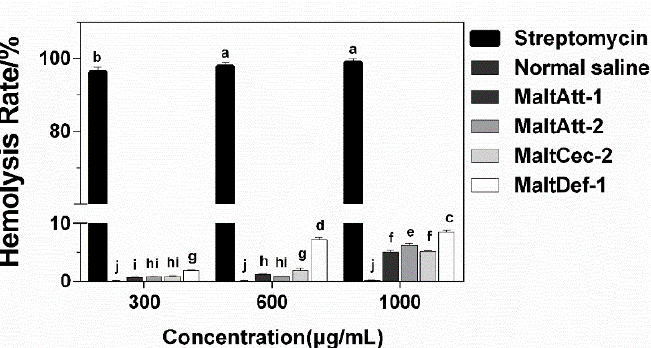
Figure 4. Hemolysis rate of M. alternatus AMPs. Different letters (a, b, c, etc.) above bars denote values that are significantly different from each other ( p < 0.05, Tukey’s test).